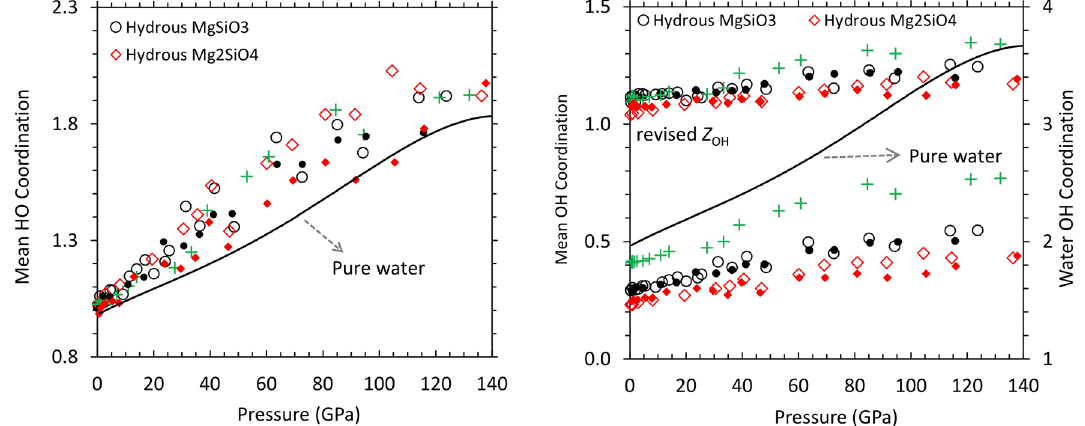
Figure 5. Mean H–O and O–H coordination numbers of hydrous MgSiO 3 with 8.2 wt% water (circles) and Mg 2 SiO 4 with 6.0 wt% water (diamonds) and 11.4 wt% water (pluses) compared to those of pure water (solid curve). The revised Z OH (right) represents the mean coordination number evaluated by considering only oxygen atoms that contribute to the coordination. The results for the corresponding iron-bearing phases are shown by small solid